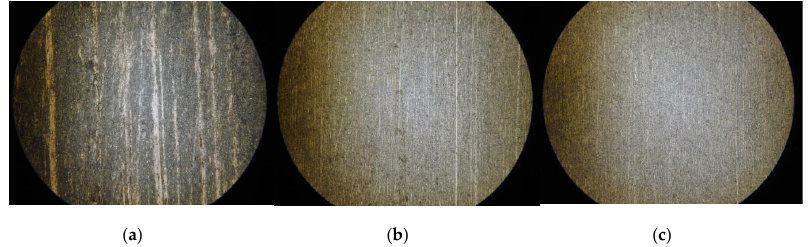
Figure 10. Observed surface by microscope after finishing. ( a ) Finished surface after EMAF processing; ( b ) finished surface after Stage 1; and ( c ) finished surface after Stage 2.